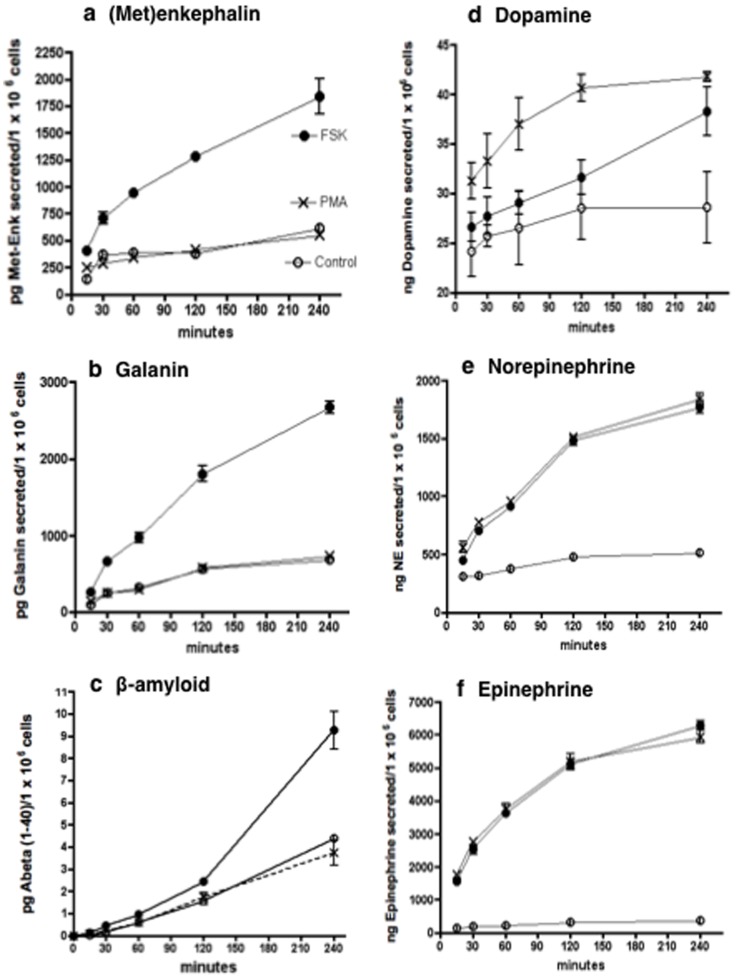
Differential regulation of neuropeptides, catecholamines, and β-amyloid secretion by activation of PKA and PKC in neuronal-like chromaffin cells.Adrenal medullary chromaffin cells in primary culture (bovine) were treated with forskolin that activates protein kinase A (PKA) that activates PKA via adenylyl cyclase stimulation and cAMP production, or with PMA (phorbol myristate acetate) that directly activates PKC. In time-course studies for treatment with forskolin or PMA for 15 minutes to 6 hours, the media was collected for measurement of secreted (Met)enkephalin and galanin neuropeptides (panels a and b, respectively), beta-amyloid peptide (Aβ(1–40), panel c), and the catecholamines dopamine, norepinephrine, and epinephrine (panels d, e, and f, respectively). Data for Control untreated cells (○), forskolin-treated cells (•), and PMA-treated cells (X) are plotted. Data for each time point represents the mean ± s.e.m. (n = 6); error bars are illustrated, and they are often smaller than the symbol.